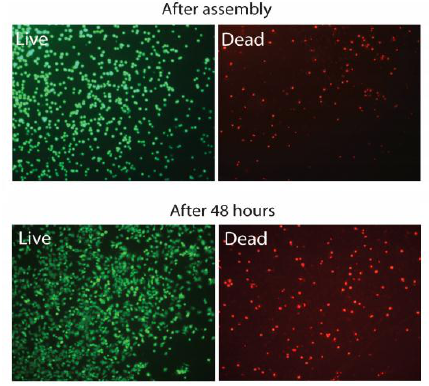
FIGURE 2: Cell viability